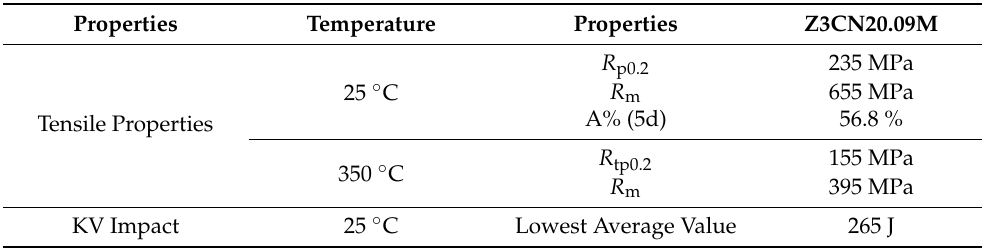
Table 1. Mechanical properties of the Z3CN20.09M ASS at RT and 350 ◦